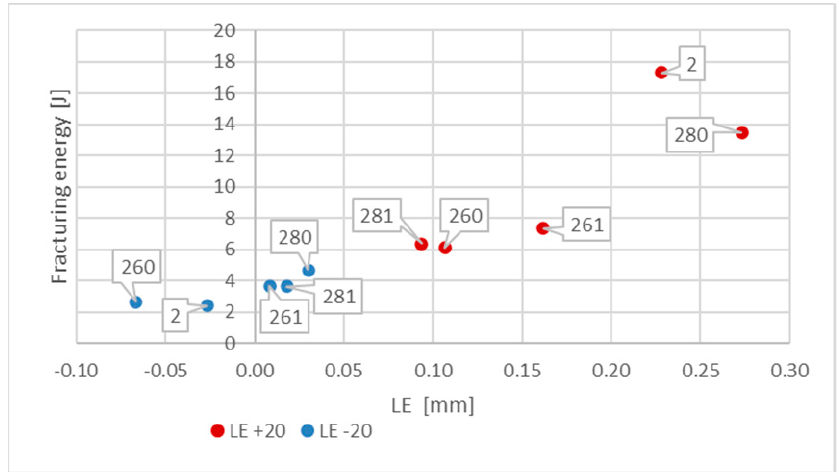
Figure 17. Relationship between averaged values of LE parameter and related values of fracturing energy W t obtained for X20Cr13 steel at di ff erent testing conditions.